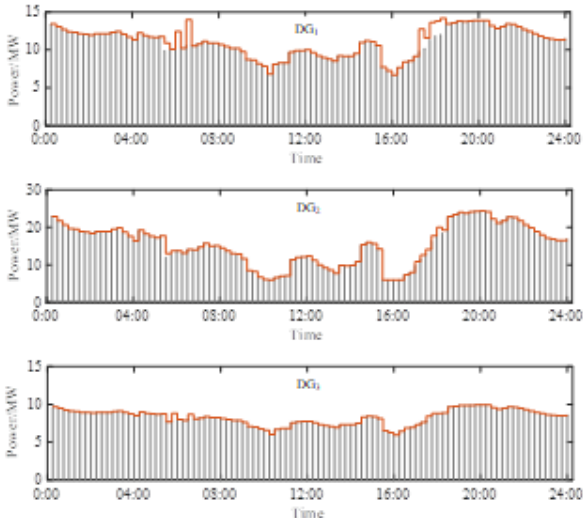
Figure 5. Unit power after robust optimization.